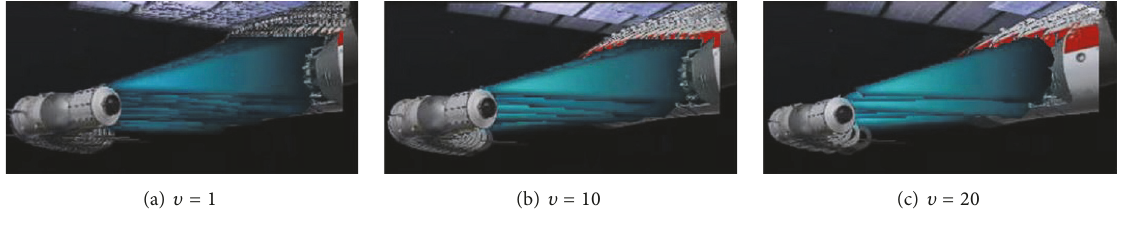
Figure 12: Target trajectory display of sequence S2.